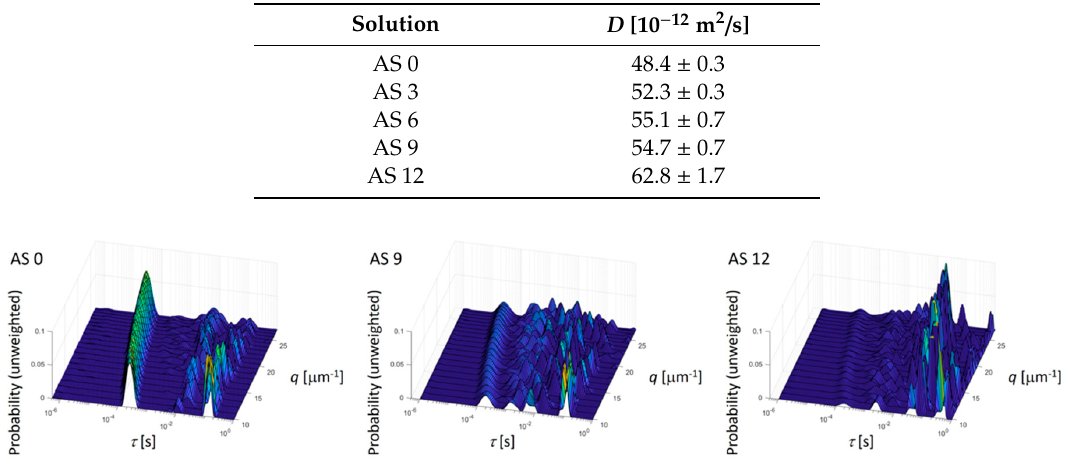
Table 3. Calculated diffusion coefficient D of the fast relaxation process of the polymer solutions AS 0 to AS 12 at 60 °C.